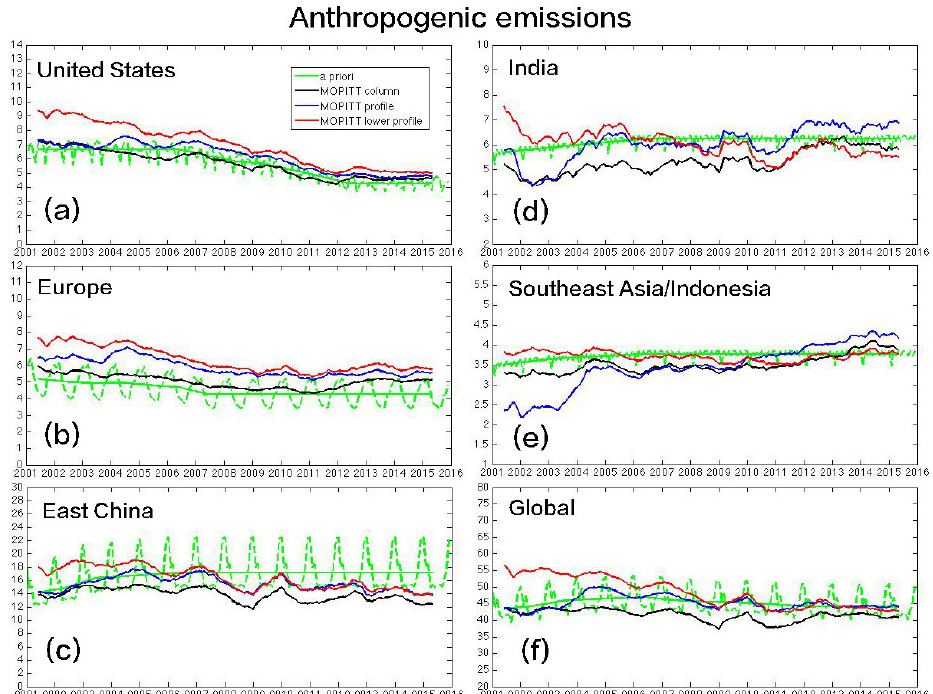
Figure 6. 12-month mean value of anthropogenic CO emissions (with unit Tgmonth − 1 ) for 2001–2015: a priori emission (green) and a posteriori emissions constrained with MOPITT column data (black), MOPITT profile data (blue) and MOPITT lower-tropospheric profile data (red). The green dash line shows the monthly a priori anthropogenic CO emissions. The region definition is shown in Fig.